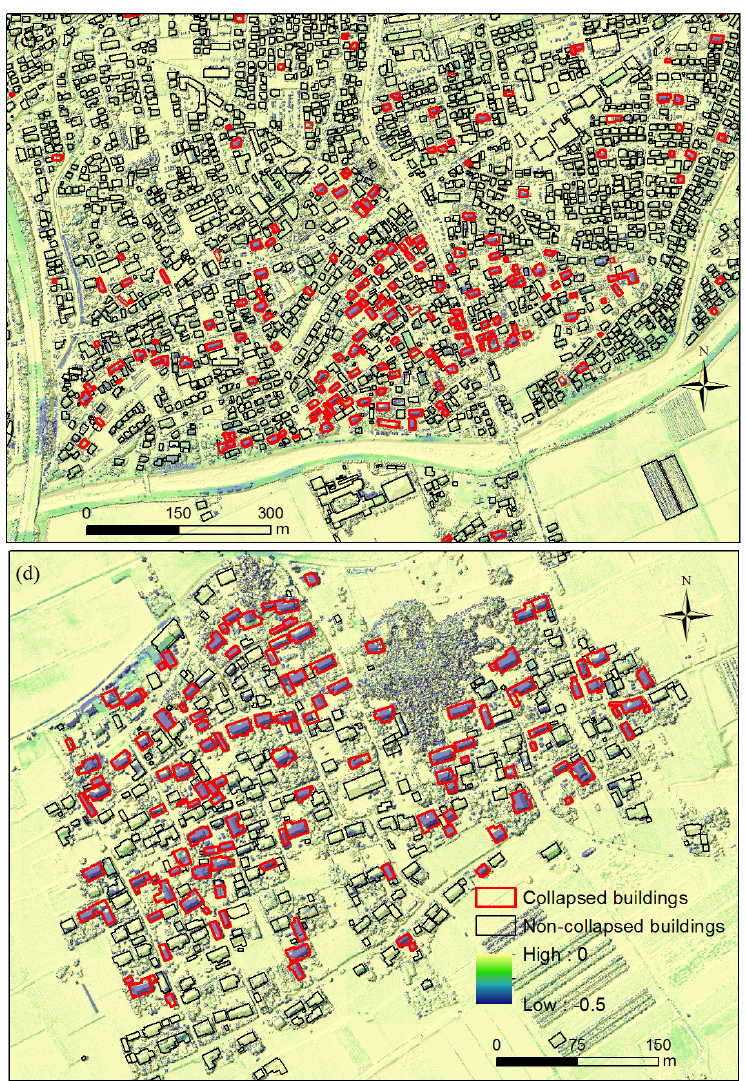
Figure 15. Close-up view of areas (c) and (d) in Fig. 14a where collapsed buildings are concentrated. The red and green polygons are the collapsed and noncollapsed buildings estimated using the threshold ( (cid:49)H< − 0 . 5m).